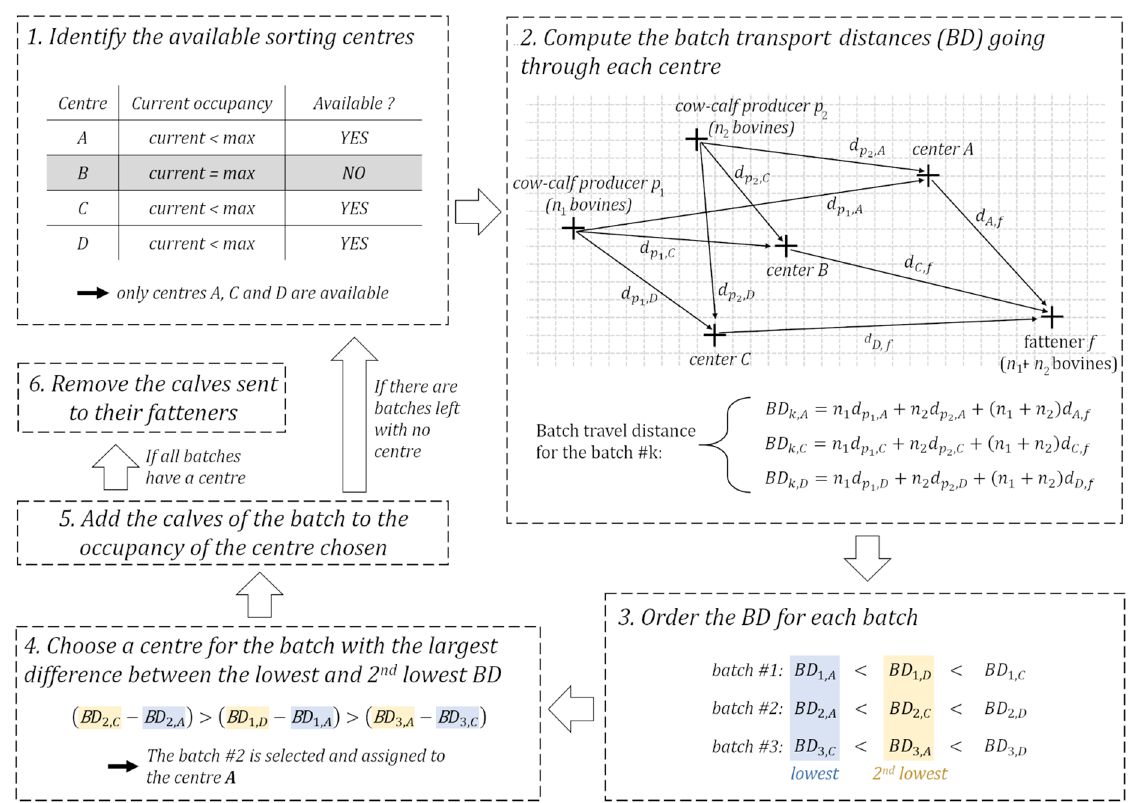
Figure 5. Schematic representation of the algorithm for a given date. The algorithm identifies centres that are already at their maximum capacity (step 1, in grey) and computes the batch transport distance (BD) for all the batches, if they went through each available centre (step 2). It identifies the lowest and second lowest values of BD for each batch (step 3) and selects the batch for which the difference is the largest (step 4). The selected batch is assigned to the centre with the lowest BD (centre A in the example) and the calves are added to the occupancy of the centre (step 5). The first five steps are repeated until all the batches are assigned to a centre. Then, the calves sent to their fatteners on the given date are